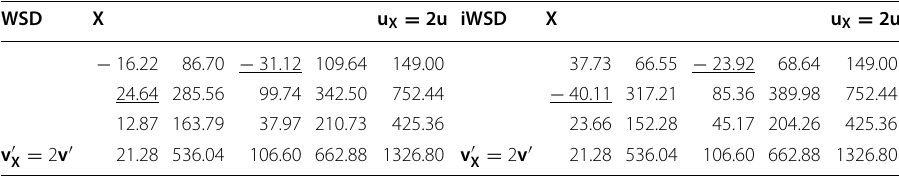
With the same location of underlined matrix elements as in Table 10